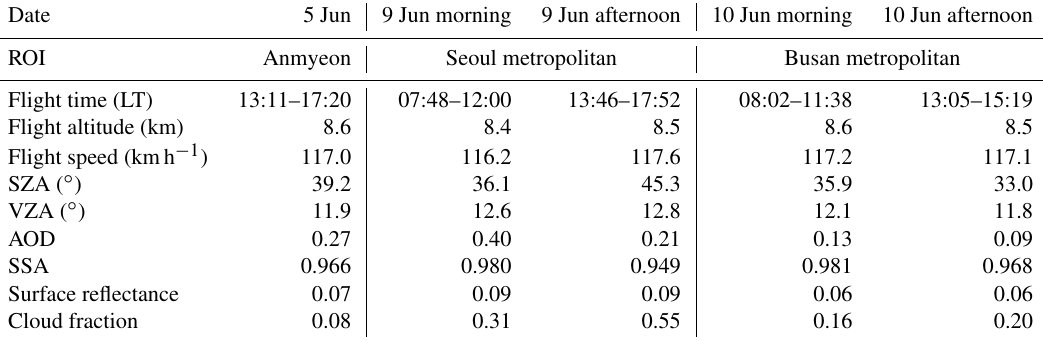
Table 1. Summary of information on the dates when NO 2 VCD was retrieved during the KORUS-AQ period (LT = UTC + 9h). The average values of GeoTASO data sets for flight characteristics, aerosol properties, geometric information, and cloud information are given